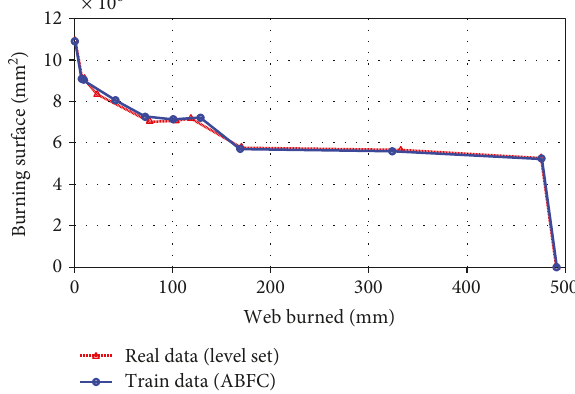
Figure 8: Comparing burning surface area real data output (from the level-set method) and training data based on the ABFC surrogate model. F = 220 , H = 50 , L = 350 , N = 13 , α = 25 , R 5 2 6 1 = 25 , H = 580 , F = 80 , F = 400 , L = 120 , L = 120 , L = 80 , 1 1 3 2 3 4 = and L 5